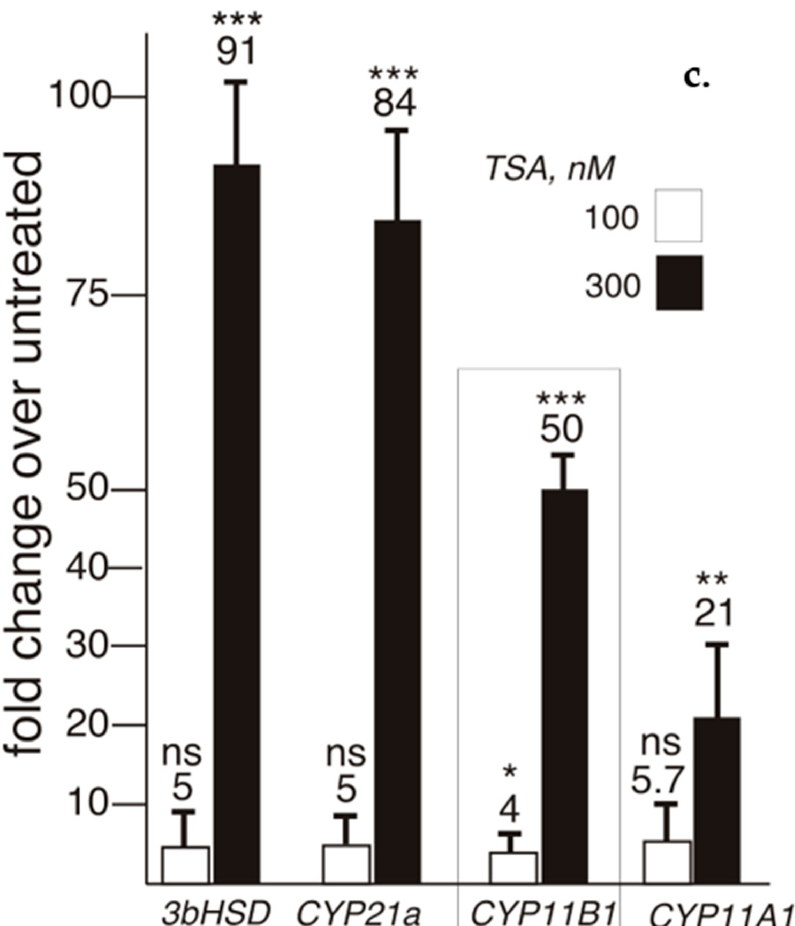
Figure 3. ( a ) qRT-PCR analysis of steroidogenic gene expression in the HAA1 cells. Gene expression in treated cells compared to the untreated is shown. Sodium Butyrate treatment leads to a prominent adrenocortical differentiation in HAA1 cell lines and gene expression for several key enzymes involved in steroidogenic hormone synthesis is highly up-regulated. ***, p < 0.001; **, p < 0.01; *, p < 0.05. ( b ) A comparison of gene expression in HAA1 cells upon 4 (black) or 6 (white) day sodium butyrate treatment. Longer treatment times increase steroidogenic gene expression. ***, p < 0.001; **, p < 0.01; ns, no significant. The data for 6-day treatment are also shown in 3A. ( c ) qRT-PCR analysis of gene expression in HAA1 cells upon treatment with another HDAC inhibitor, Trichostatin A (TSA). TSA, similarly, is effective in inducing steroidogenic gene expression in the HAA1 cells as sodium butyrate. Notice that CYP11B1 gene expression is efficiently induced in HAA1 cells derived from ZR cells. ***, p < 0.001; **, p < 0.01; *, p < 0.05; ns, no significant. To confirm the RNA expression data at the protein level, we performed immunoflu- orescence staining analysis using antibodies on CYP11A1 and HSD3B2. CYP11A1 and HSD3B2 immunostaining is prominent only in the HDACi-treated cells (Figure 4). To examine protein expression in HDACi-treated cells in more detail, we performed a Western blot for StAR. The StAR gene encodes for the steroidogenic acute regulatory protein that regulates cholesterol transport within the mitochondria, a rate-limiting step in the produc- tion of all steroid hormones. The expression of StAR was elevated upon HDACi treatment in HAA1 cells (Supplementary Figure